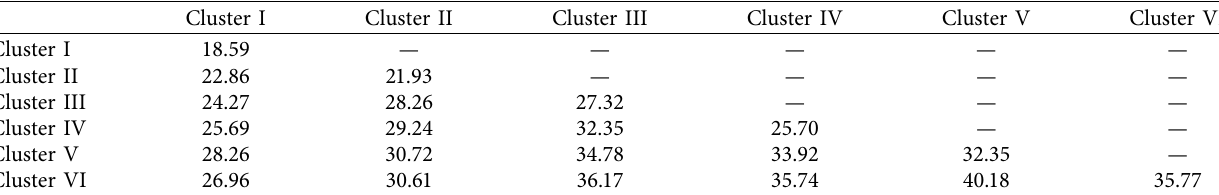
Table 4: Intracluster (diagonal) and intercluster distance among 6